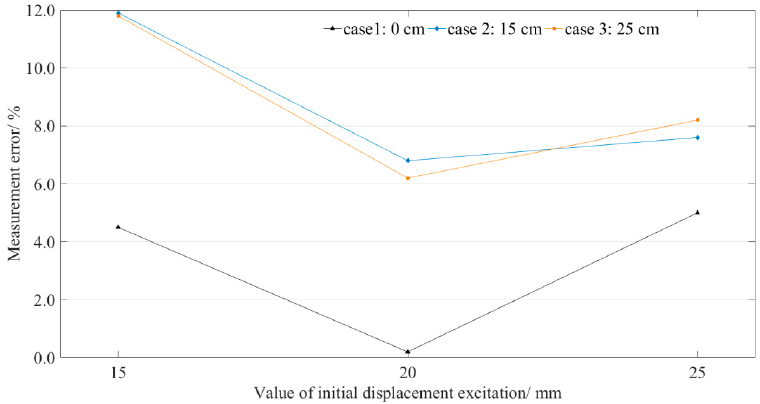
Figure 13. Measurement point #1: measurement errors distribution.